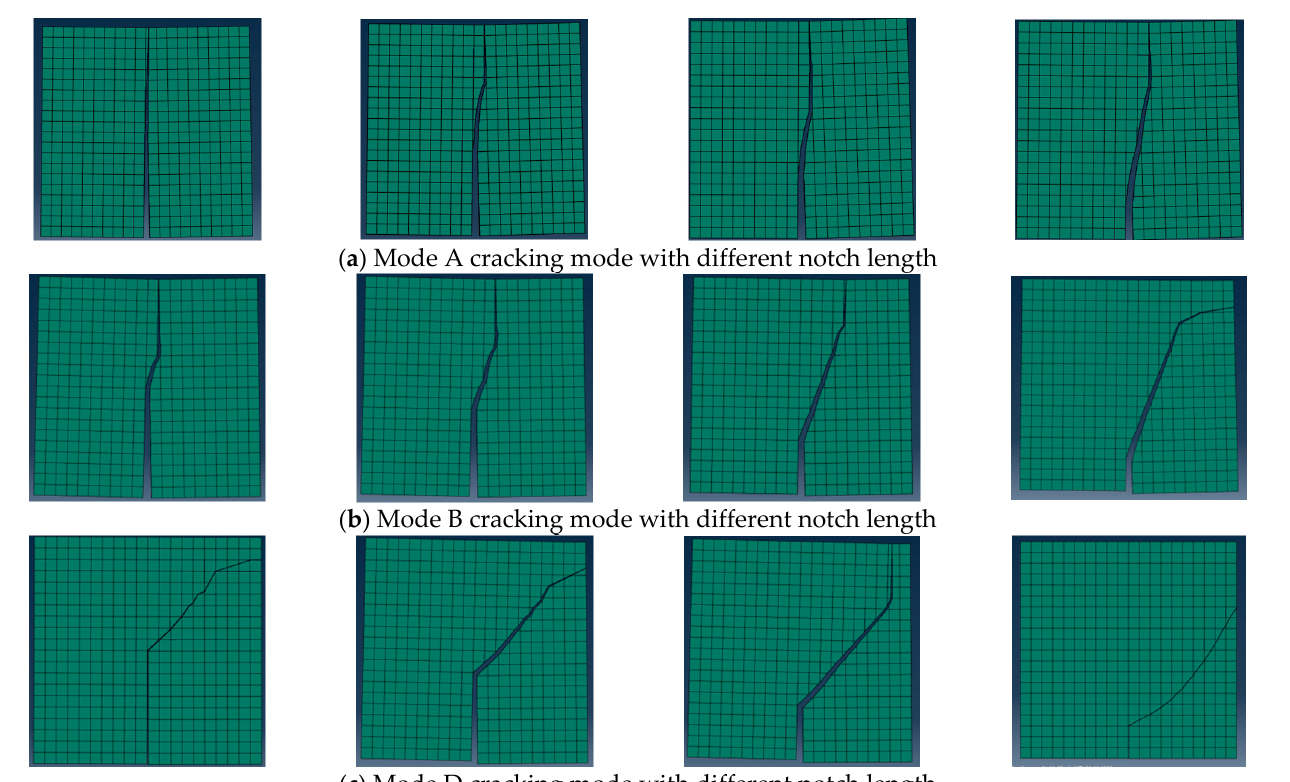
Figure 9. Numerical Arcan test results of mixed-mode cracking with different notch lengths (40, 30, 20 and 10 mm).